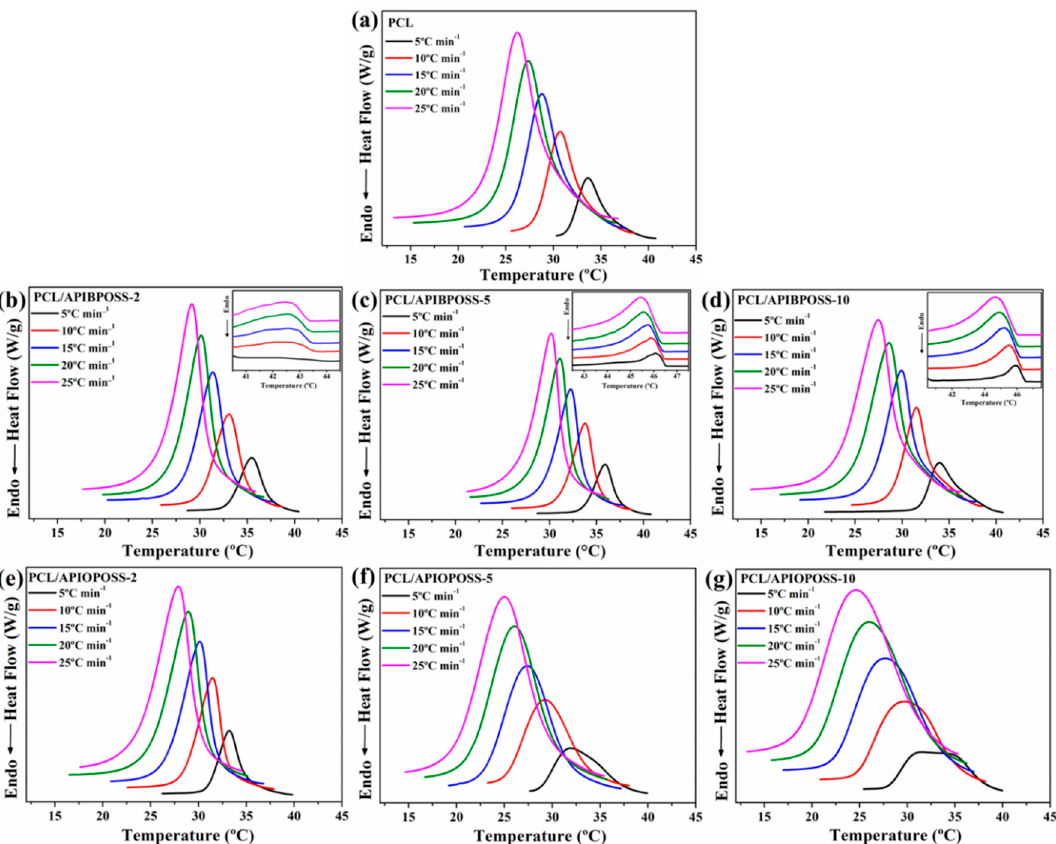
Figure 1. DSC traces of ( a ) PCL, ( b – d ) PCL / APIBPOSS nanocomposites, and ( e – g ) PCL / APIOPOSS nanocomposites during cooling at various cooling rates.